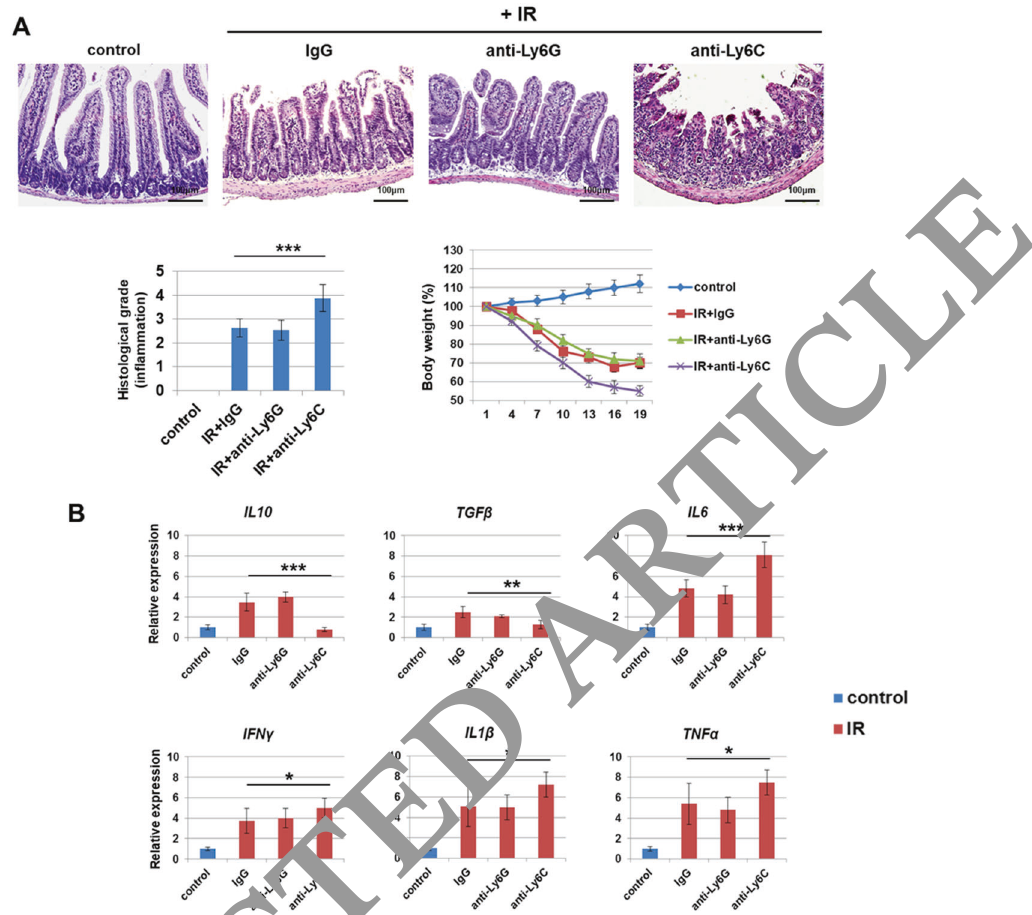
Fig. 2 Depletion of mMDSCs exacerbates radiation-induced intestinal in fl ammation. Mice were tail-vein injected with either anti-IgG, anti- Ly6G, or anti-Ly6C (250 μ g/mouse) four times per week after irradiation. All the results were determined 21 days after irradiation. A Photomicrographs of colon sections, histological grades, and body weights after depletion of Ly6G or Ly6C. Scale bar = 100 μ m. B The relative expression of cytokines (IL10, TGF β , IL6, IFN γ , IL1 β , and TNF α ) in the intestines of irradiated mice were measured by qRT-PCR. The data are represented as mean ± SD (n = 8). * P < 0.05, ** P < 0.01, *** P < 0.001 vs. IR + IgG. IR